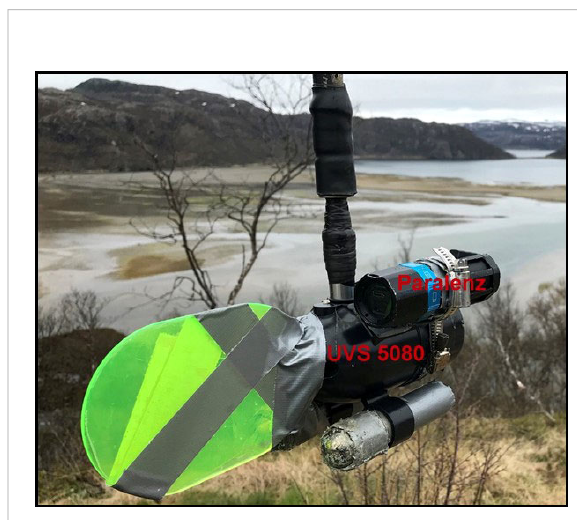
FIGURE 2 The two camera modules used for video recording. The HD Paralenz camera strapped to the live UVS 5080